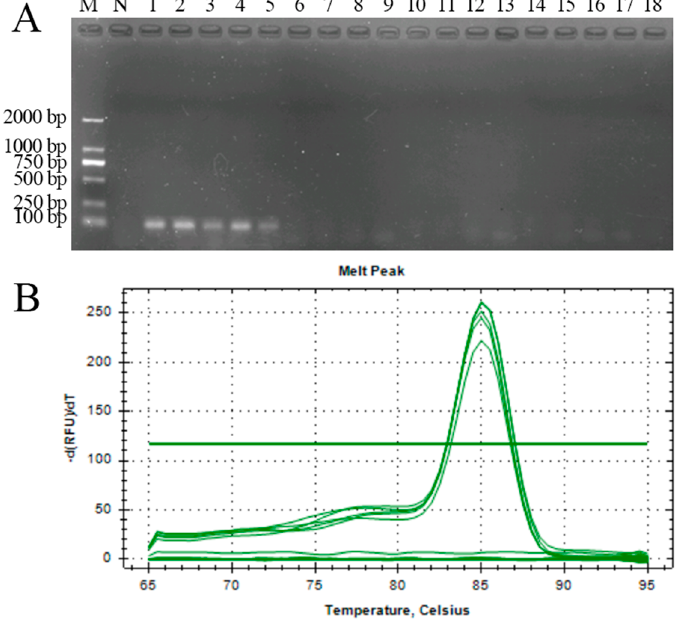
Figure 5. Specificity of qPCR detection of A. phaeospermum ( A ) Conventional PCR amplification with the 33-F/33-R primer; ( B ) melting curves of the real-time quantitative PCR. M: DL2000 marker; N: negative control; 1–18: strain number is the same as in Table